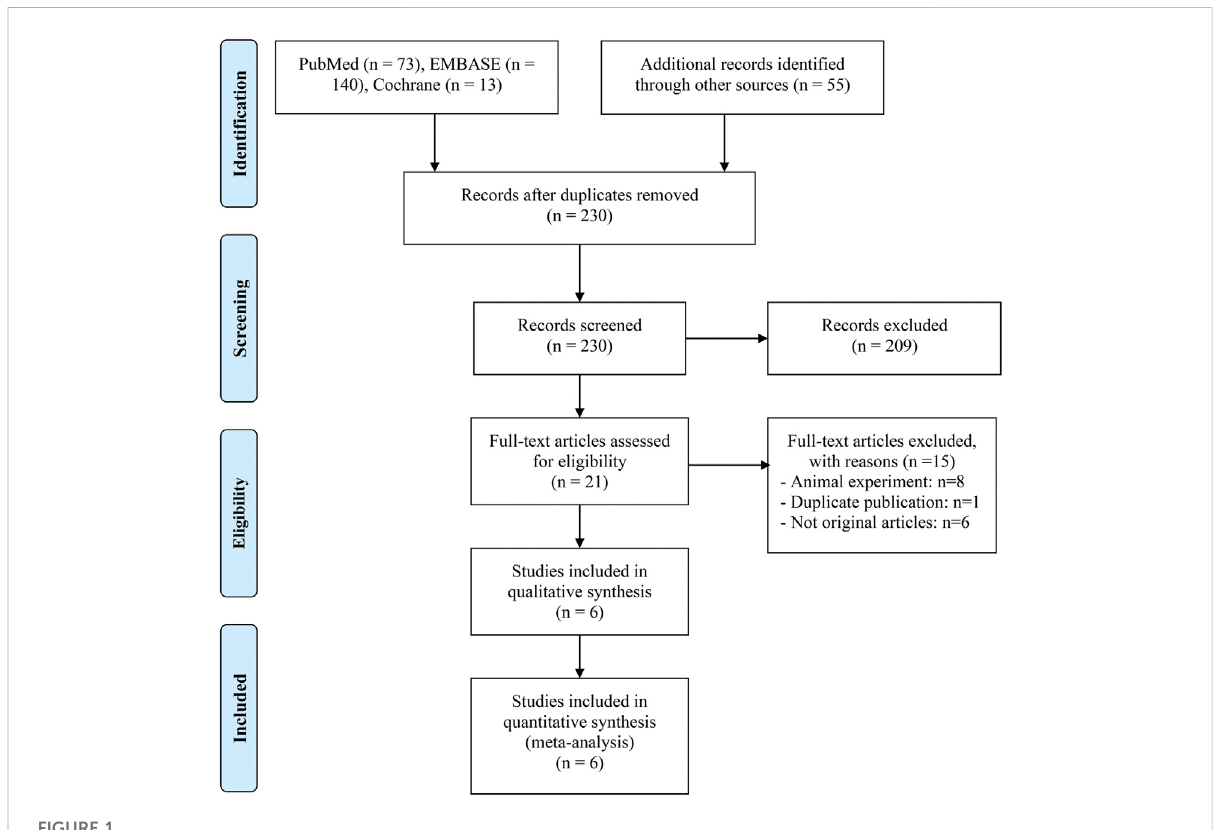
FIGURE 1 The fl ow diagram of identifying eligible